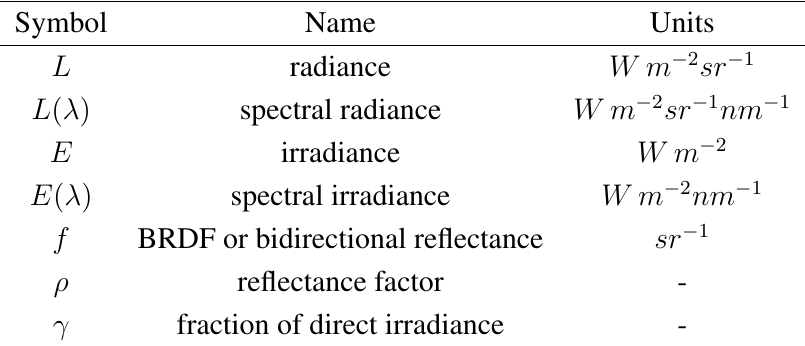
Table 1. List of radiometric symbols and